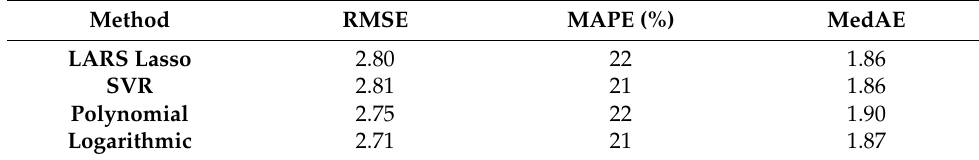
Table 6. Performance of proposed prediction models for